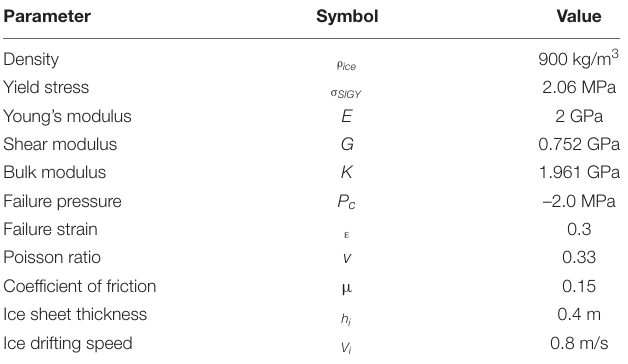
Frontiers in Marine Science |